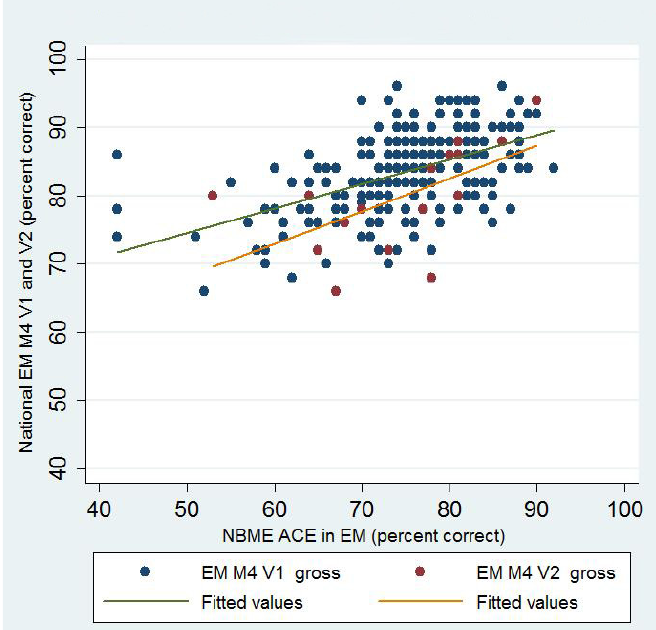
Figure 1. Correlation of NBME EM-ACE and National EM M4 V1 and V2.